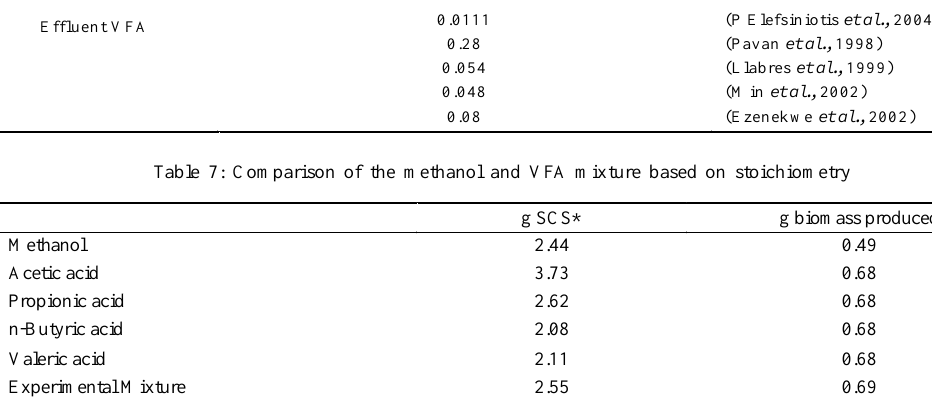
*supplemental carbon source, values are given per grN-NO3